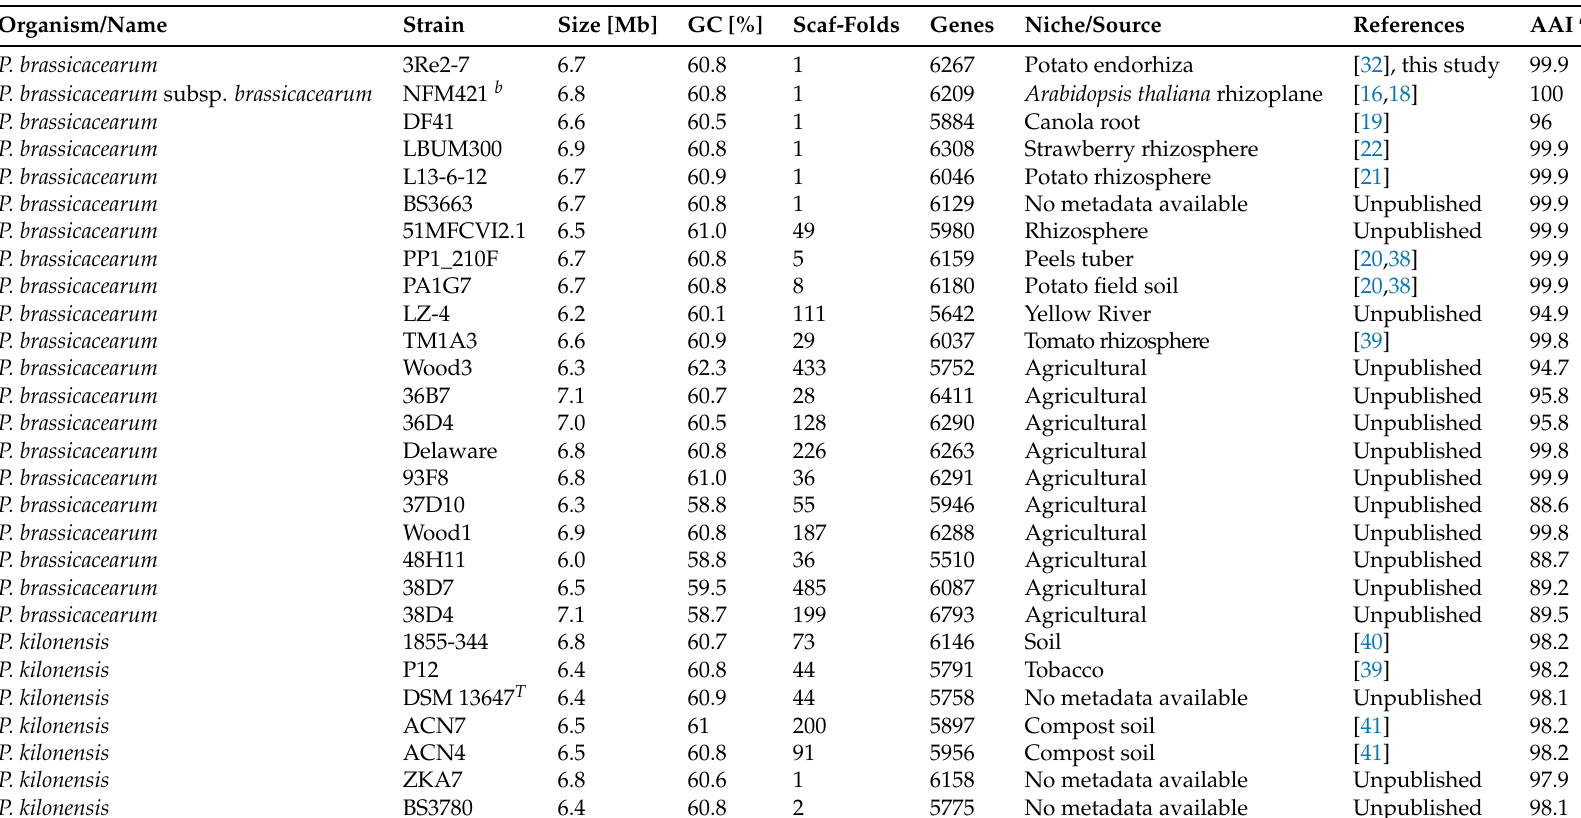
Table 1. General genome features of publicly available genomes of Pseudomonas brassicacearum and P. kilonensis strains. https://www.ncbi.nlm.nih.gov/genome/ genomes/3640, last accessed